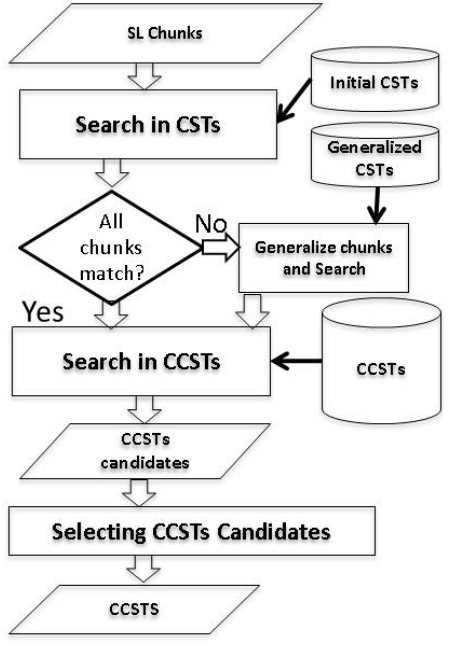
Fig. 5 Matching Algorithm for